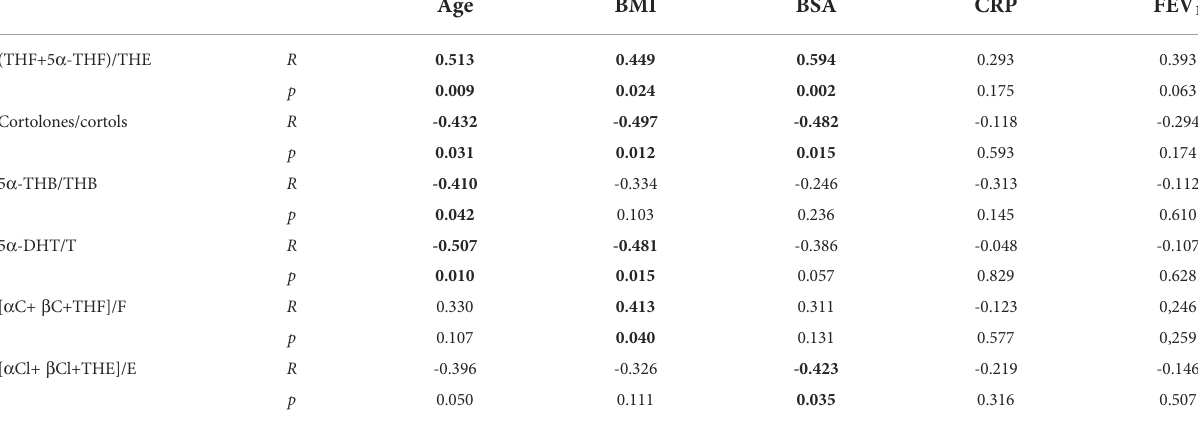
TABLE 4 Spearman ’ s rank correlation coef fi cients and p values in CF